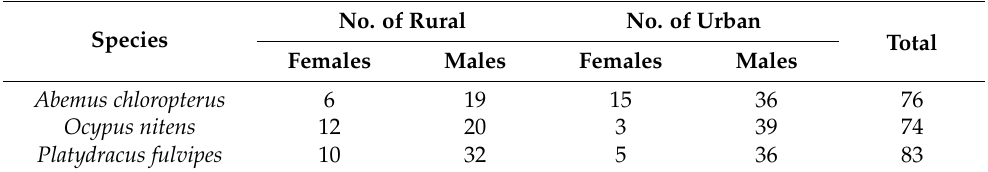
Table 1. Number of the sampled rove beetle individuals in rural and urban habitats, April—June 2020. No. of Species